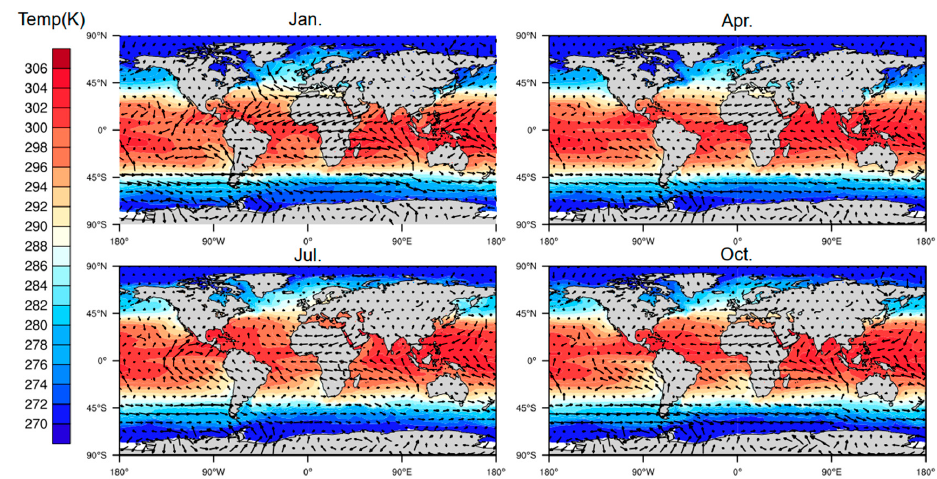
Figure 6. Average MBLH over four months based on the 2007–2011 CDAAC atmprf bending angle products.